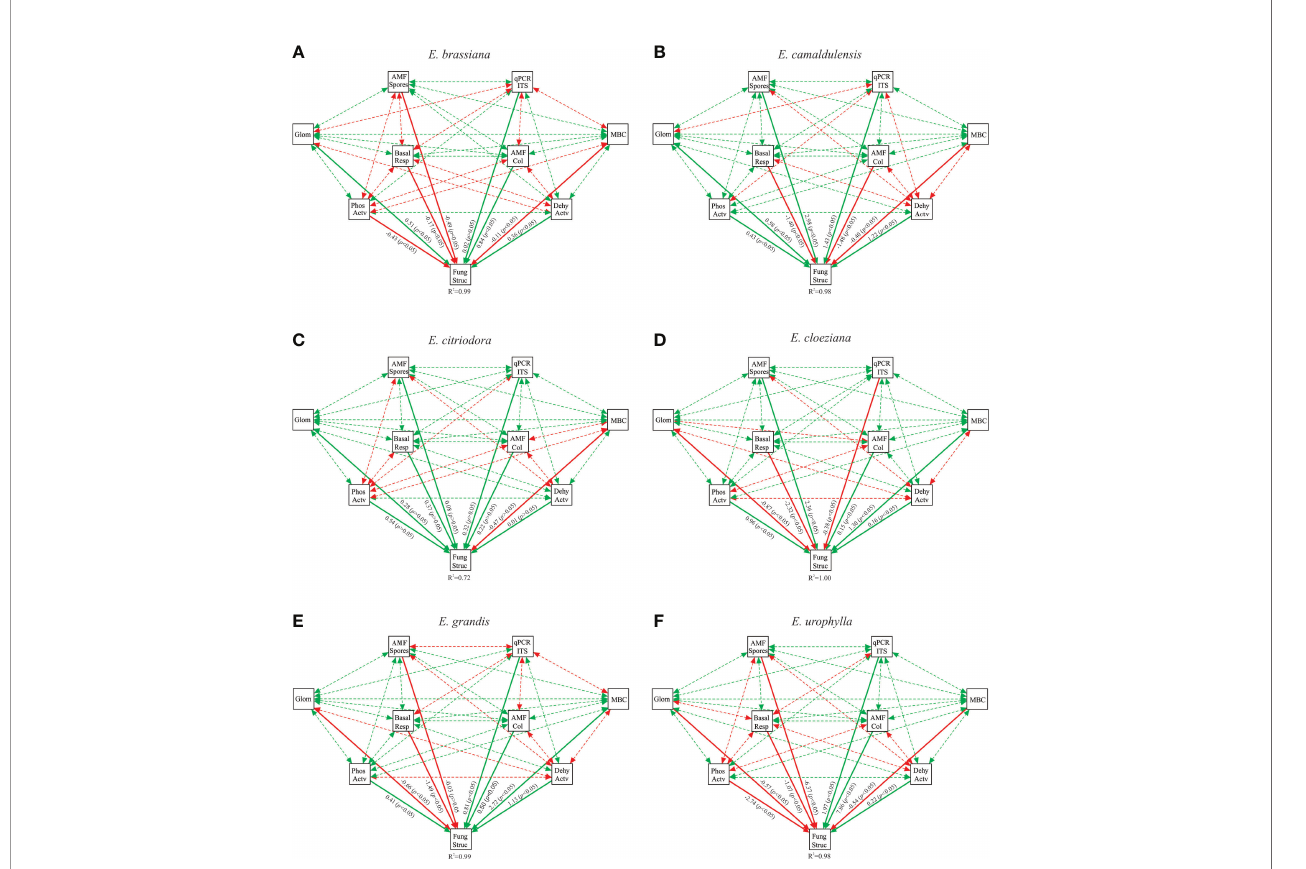
FIGURE 4 | Structural equation model of correlations between soil microbiological attributes and the soil fungal structure community for Eucalyptus brassiana (A) , E. camaldulensis (B) , E. citriodora (C) , E. cloeziana (D) , E. grandis (E) , and E. urophylla (F) . Values associated with solid arrows represent signi fi cant standardized path coef fi cients. Solid or dashed arrows indicate direct or indirect correlation, respectively. Red arrows indicate negative correlation while green arrows indicate positive correlation. The R2 values associated with the fungal structure indicate the proportion of variation explained by correlations with other variables. AMF Spores, arbuscular mycorrhizal fungi (AMF) spore numbers; AMF Col, root colonization by AMF; Glom, easily extractable glomalin-related soil protein; Phos Actv, acid phosphatase activity; Dehy Actv, dehydrogenase activity; MBC, microbial biomass carbon; Basal Resp, basal respiration and qPCR ITS, ITS copy number in